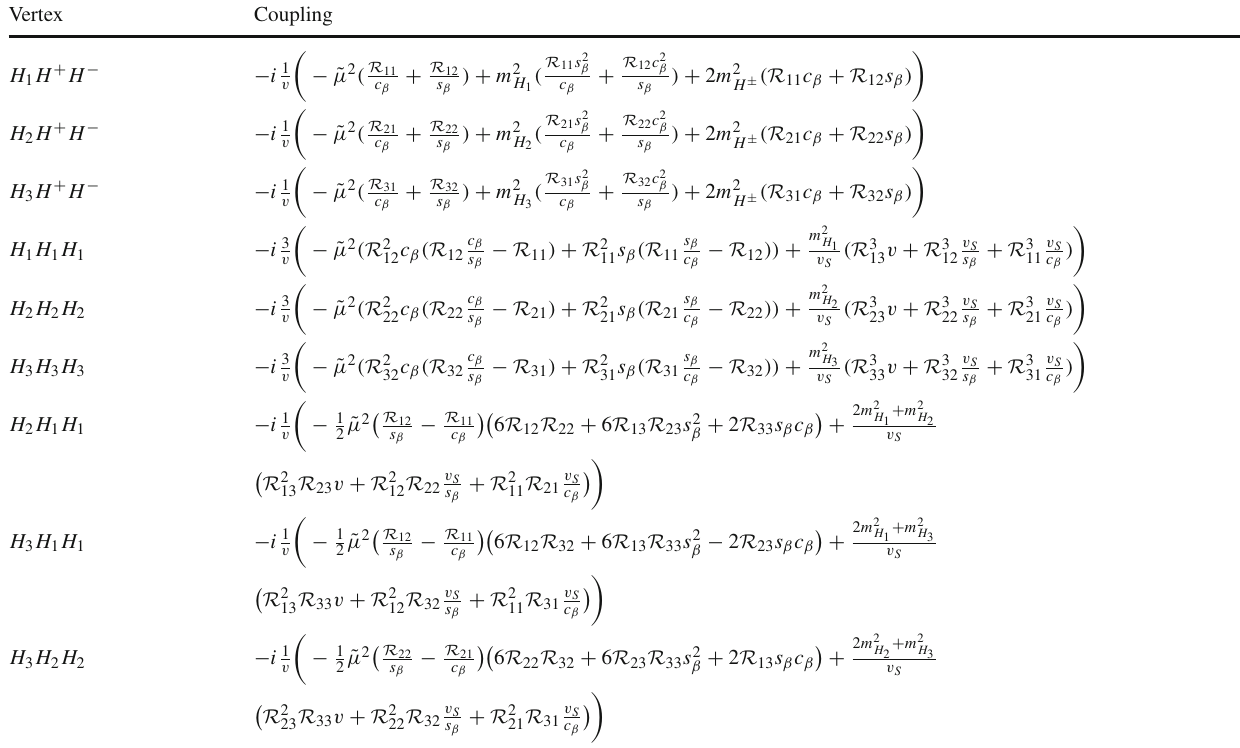
Table 1 Trilinear Higgs boson self-interactions ( i λ 3 H ) in the Feynman gauge within the N2HDM Vertex